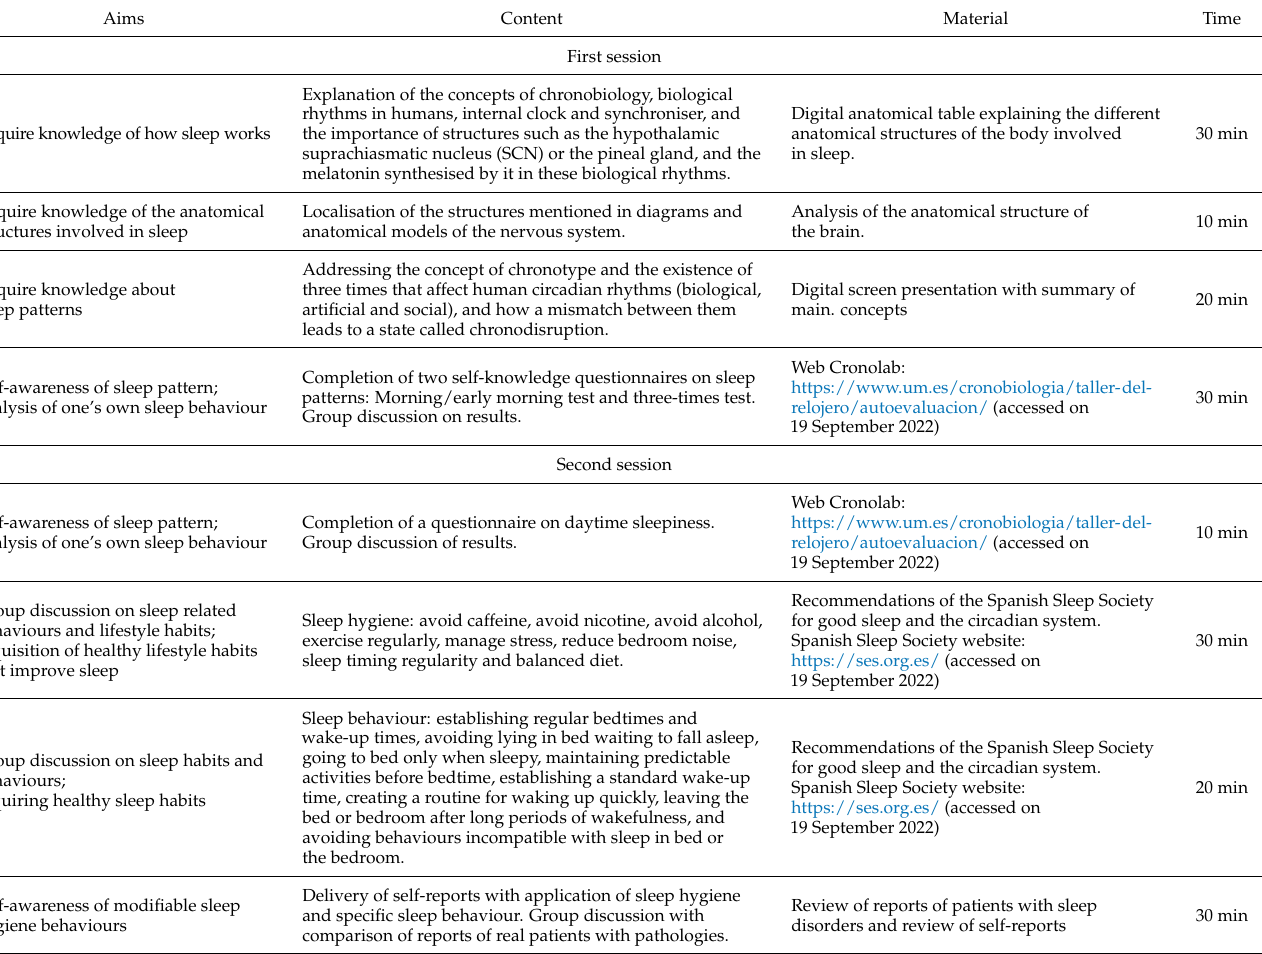
Table 1. Distribution of the sessions of the sleep quality programme for nursing